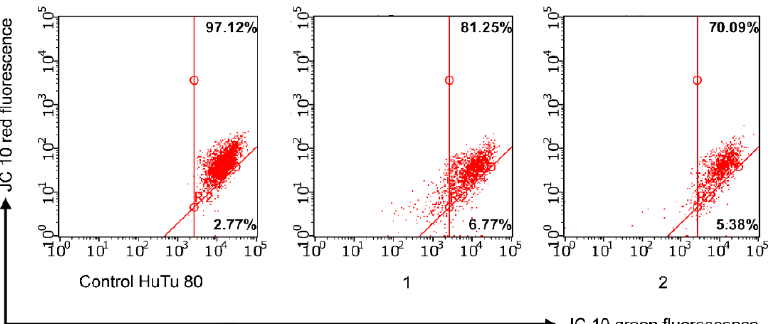
Figure 4. Flow cytometry analysis of HuTu 80 cells treated with compound 2a . 1– 2a at IC 50 /2 concentration (12.5 µ M); 2– 2a at IC 50 concentration (25 µ M).